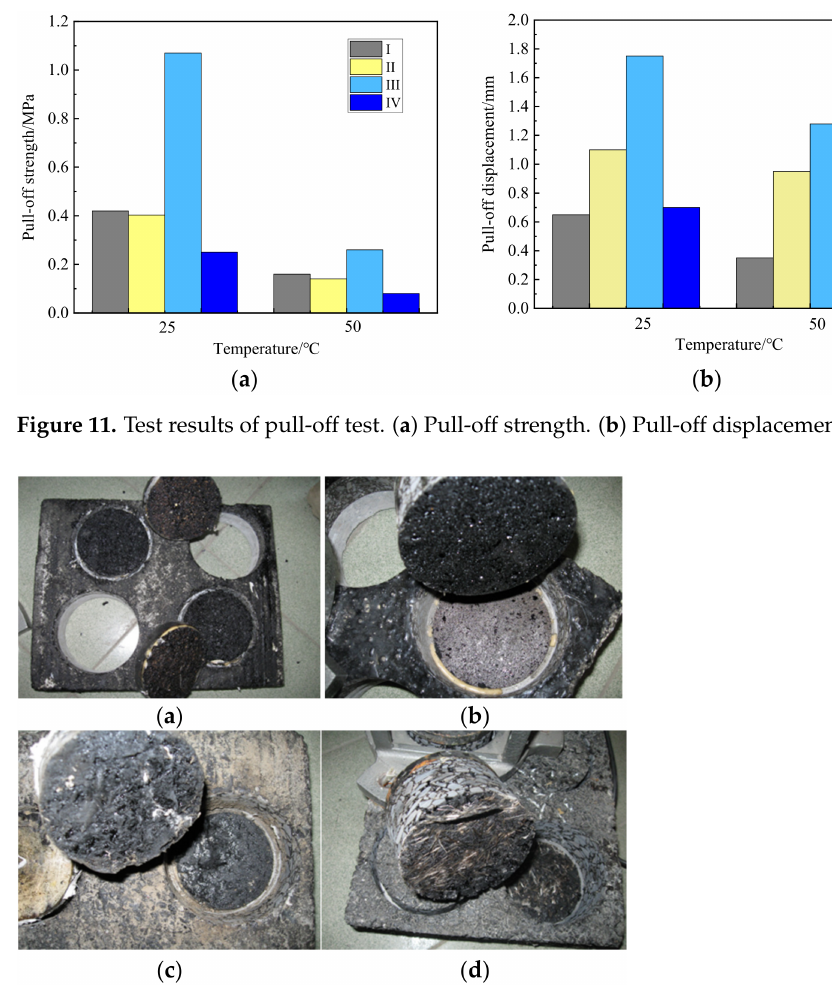
Figure 12. Sections of specimens after pull-off test. ( a ) Scheme I. ( b ) Scheme II. ( c ) Scheme III. ( d ) Scheme